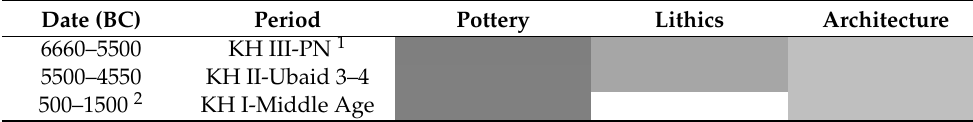
Table 1. The cultural sequences at Kendale Hecala.